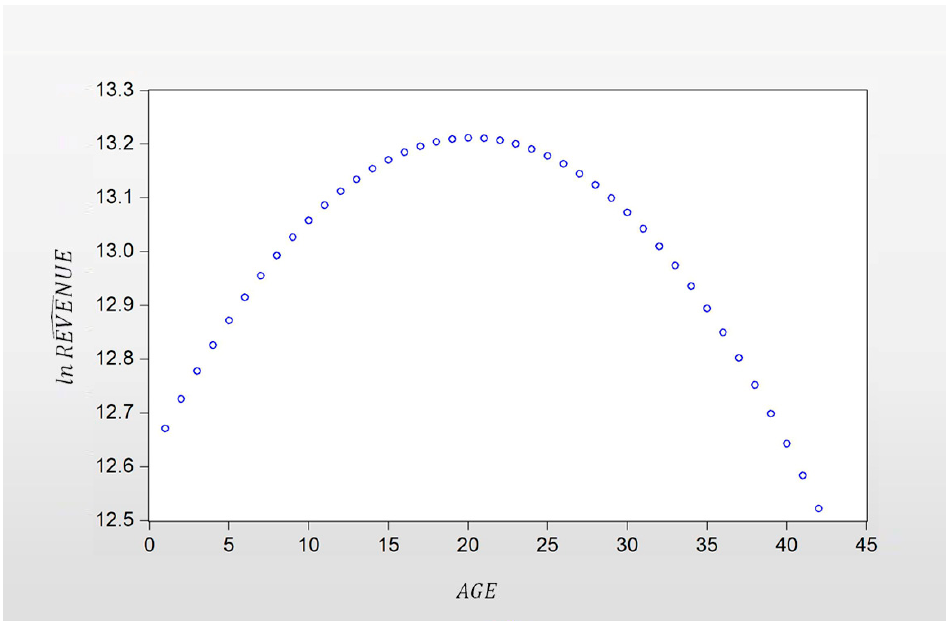
Figure 1. Life cycle curve of SMMCI.